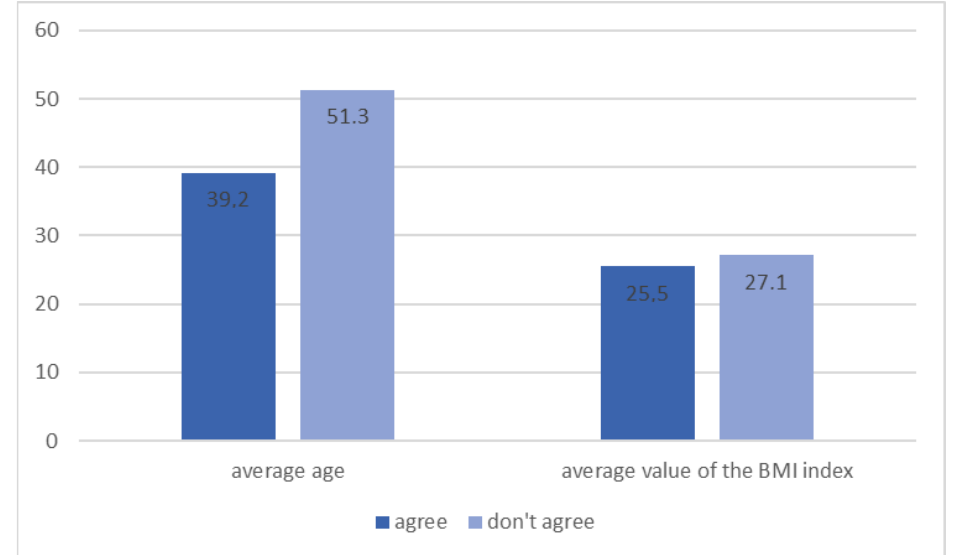
Figure 6. Patients’ opinion on proper eating habits in preventing the development of diabetes depending on the average age and BMI value ( n = 131, p = 0.046).